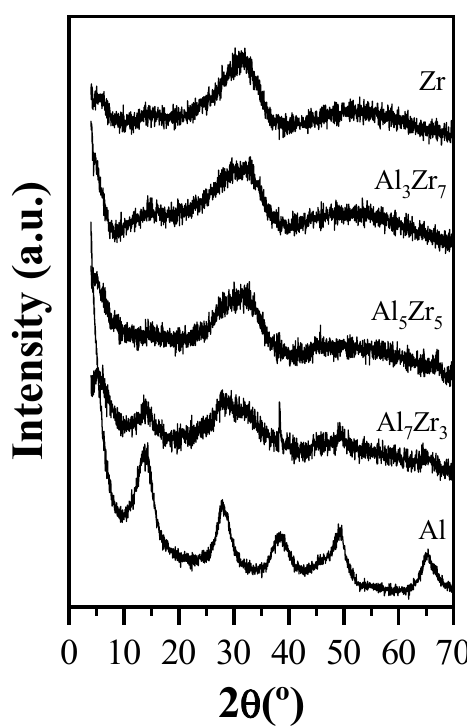
ff raction (XRD) patterns of Al, Zr, and Al Figure 1. Powder X-ray diffraction (XRD) patterns of Al, Zr, and Al x Zr y catalysts. Figure 1. Powder X-ray di